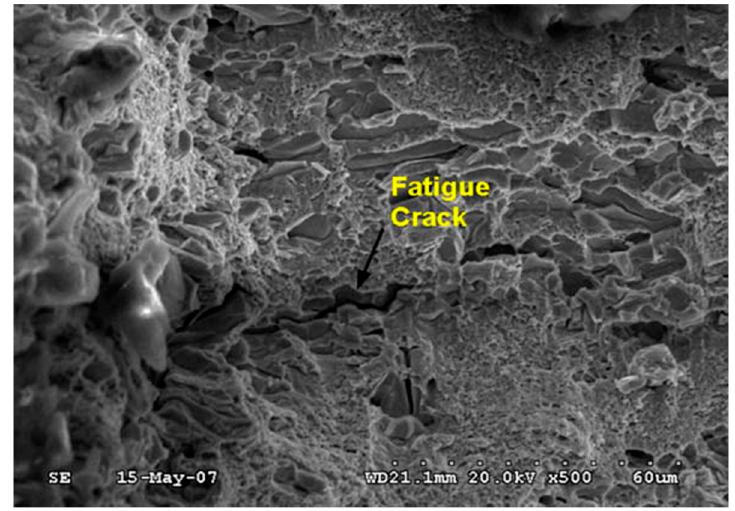
Figure 9. SEM cross-sectional image showing propagation of fatigue crack [146].